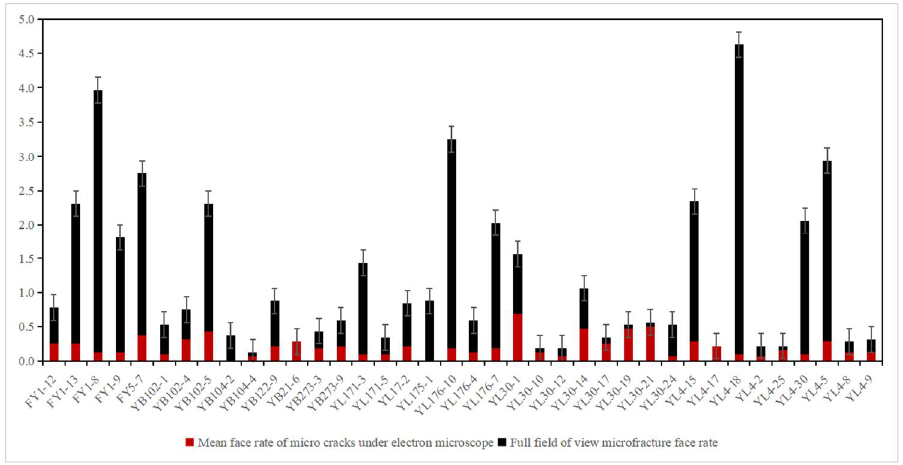
Figure 11. Micro-slice photos and scanning electron microscope full-scale micro-fractures hole ratio